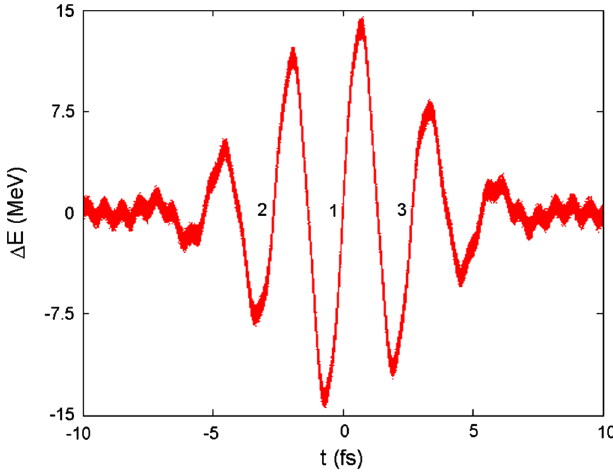
FIG. 5. (Color) Longitudinal phase space of the beam after interaction with the few-cycle laser (bunch head at